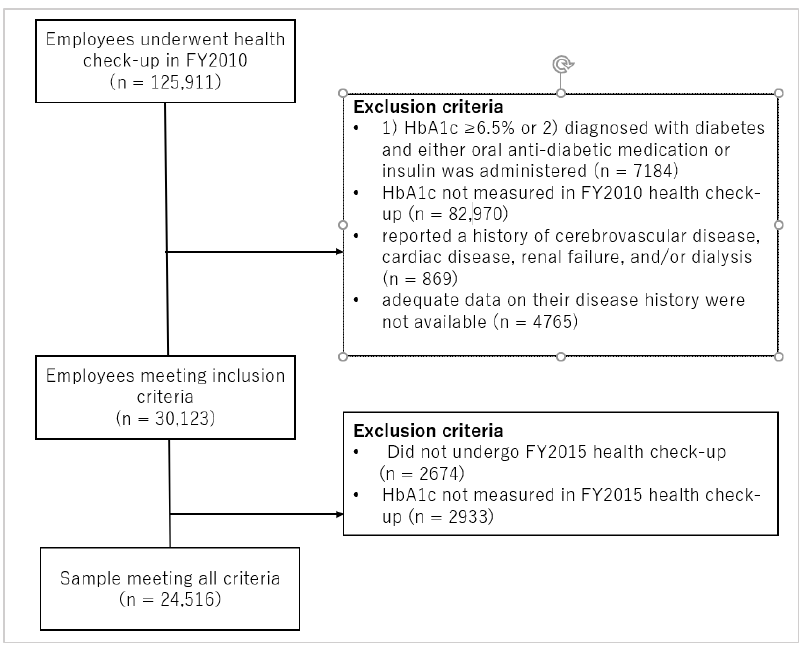
Figure 1. Flowchart of inclusion and exclusion criteria.